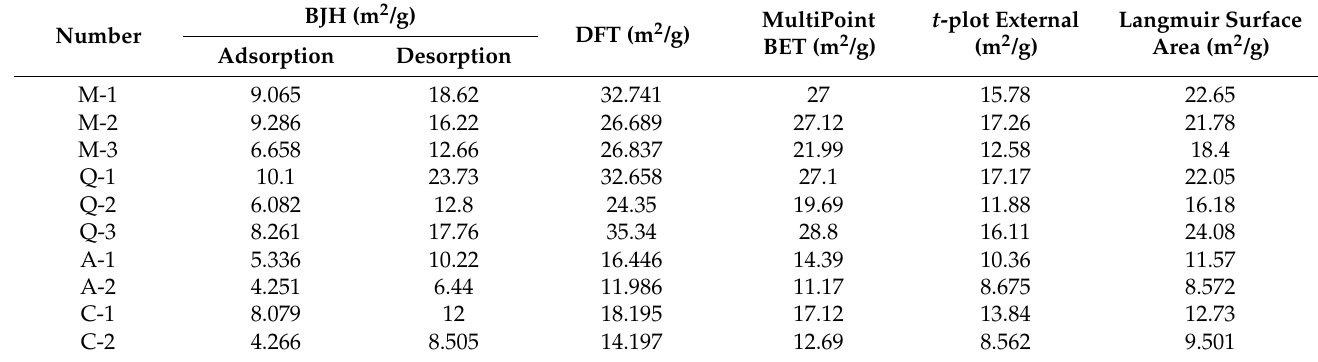
Table 2. Surface area of the shale samples by the various methods.